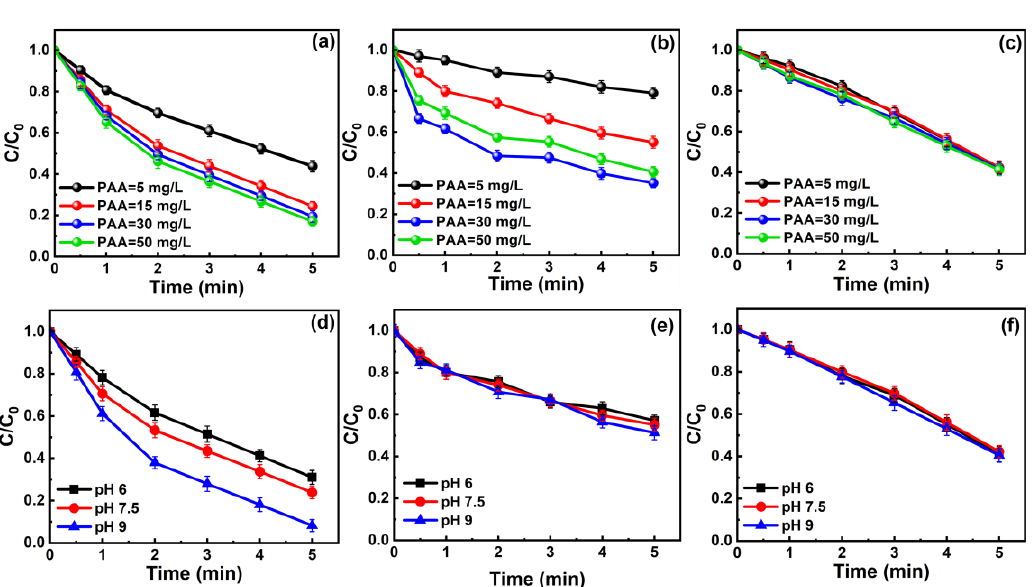
Figure 2. Effect of PAA dosage and pH on the removal of ( a , d ) RB5, ( b , e ) ANL, and ( c , f ) PVA in the MPUV/PAA/H 2 O 2 system. Conditions: [Contaminant] 0 = 10 mg/L, [PAA] 0 = 15 mg/L, [H 2 O 2 ] 0 = 3 UV fluence rate = 5 mW/cm 2 , UV exposure time = 5 min, T = 25 ± 1 °C.